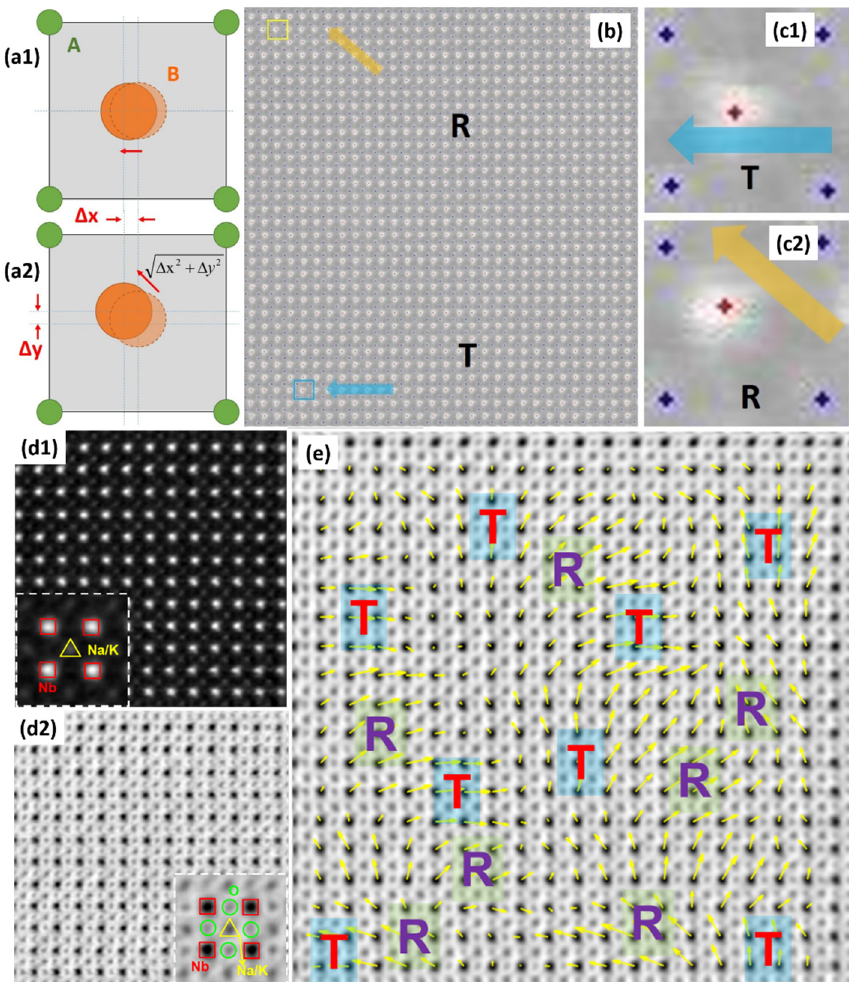
Figure 2. Local symmetry in nanodomains. ( a1 , a2 ) Schematic showing R and T symmetries with B atom displacement along the cube diagonal and pseudo cubic axes with respect to A (Na/K/Bi) atoms. ( b ) STEM HAADF lattice image on the domain boundary after peak finding, indicating the R and T phases. ( c1 , c2 ) Enlarged photos of the regions in ( b ) within the yellow box, showing R and T symmetries. Reproduced from: Ref. [44] Copyright 2016 American Chemical Society. Phase coexistence with gradual polarization rotation. ( d1 , d2 ) Simultaneously acquired STEM HAADF and ABF images at a domain boundary, with enlarged images inset. ( e ) Atomic displacement vector maps of centre Nb columns with respect to O